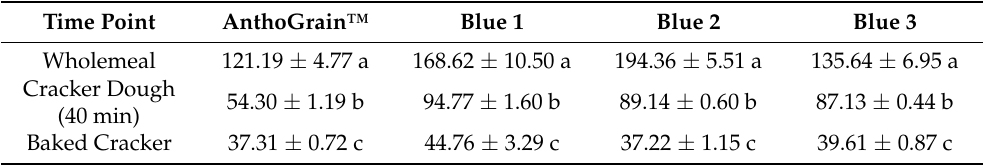
Table 1. Total anthocyanin content (mg anthocyanin/kg wholemeal) of AnthoGrain™ and